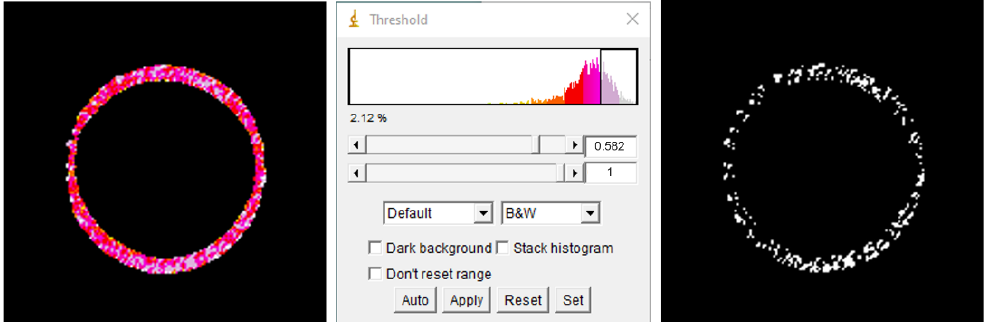
Figure 4. Stacked GP distribution of DM RBC. The graph shows the number of pixels (frequency, on the y -axis) as a function of GP (on the x -axis) evaluated for a stack of 20 RBC from DM subjects. The LUT reported along with the histogram allowed associating a colour to each pixel, representing the corresponding value of fluidity.